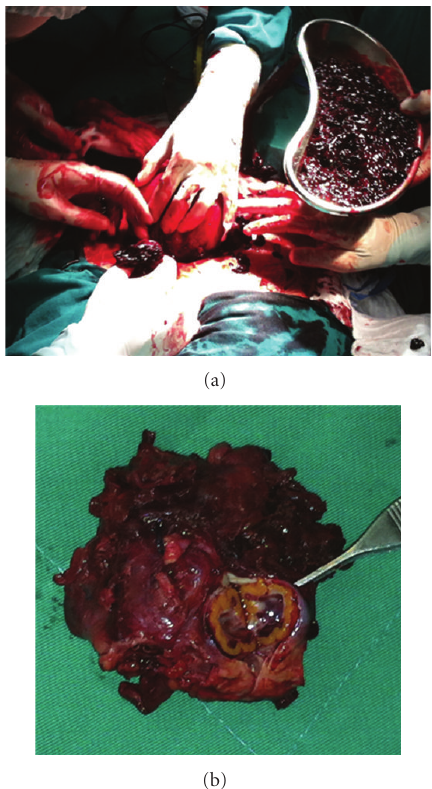
Figure 3: (a) Intraoperative situation, showing the presence of a great amount of coagulum in the pelvic cavity as well as lesions in the left uterine tube and ovary; (b) surgical specimen, showing left ovary with intact corpus luteum and small fragment of the left uterine